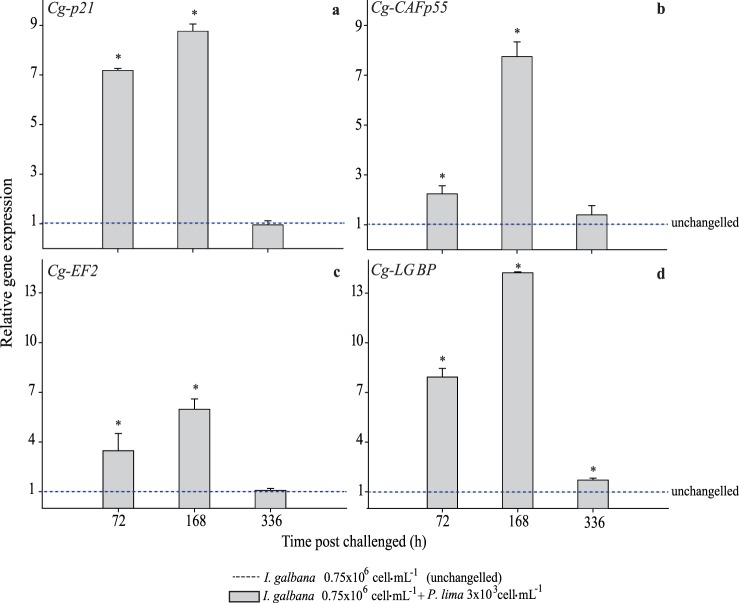
Analysis of relative expression (qPCR).
Crassostrea gigas genes related to regulation cell cycle (a, b, c) and immune system (d) after challenge to T2 (3×103 cells mL−1). Bars represent standard deviation (SD) from the mean value, normalized with actin, tubulin and 28S ribosomal RNA and relative to calibrator (dotted line). Asterisk indicates significant differences between treatment and control (p<0.05 in Fisheŕs HSD).